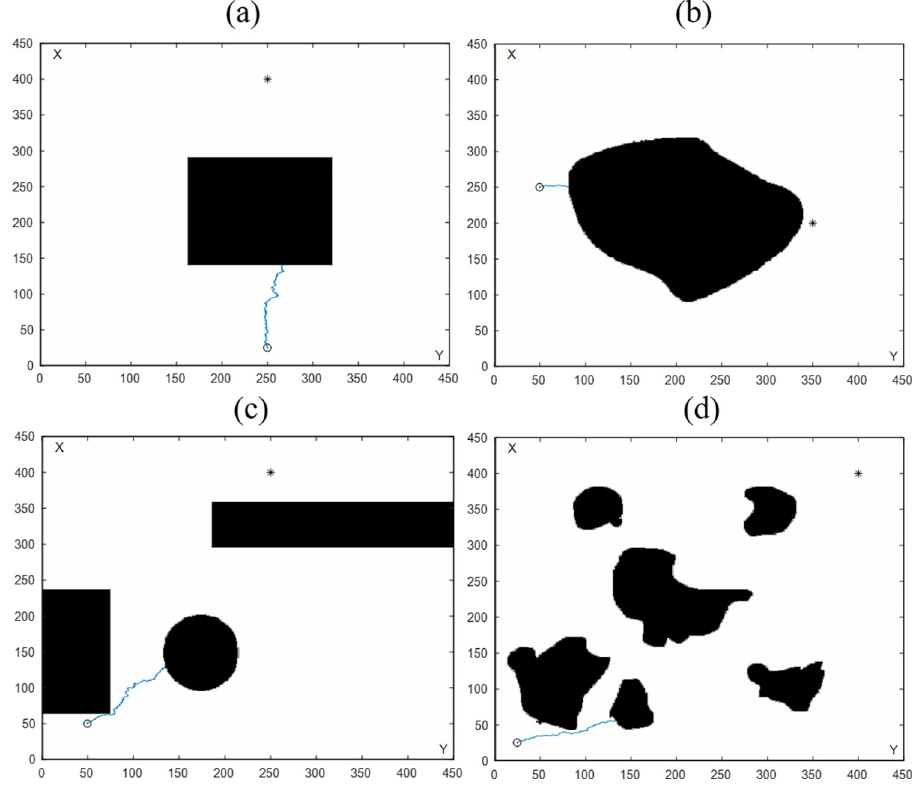
Fig 11. Comparison of path planning results by the conventional BAS algorithm on four different maps. (a) Single regular obstacle. (b) Single irregular obstacle. (c) Multiple regular obstacles. (d) Multiple irregular obstacles.